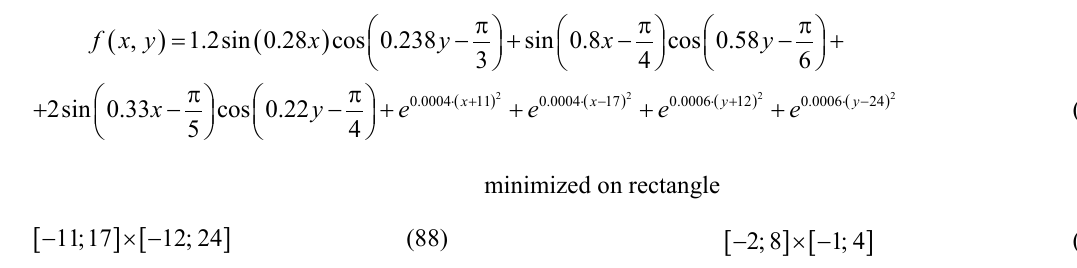
Fig. 6. The 16 local minima (two of which are unseen from this view angle), including both the local boundary minima and the global minimum of surface (87) on rectangle (88) (the surface value axis is shown in reverse direction for easier observation of